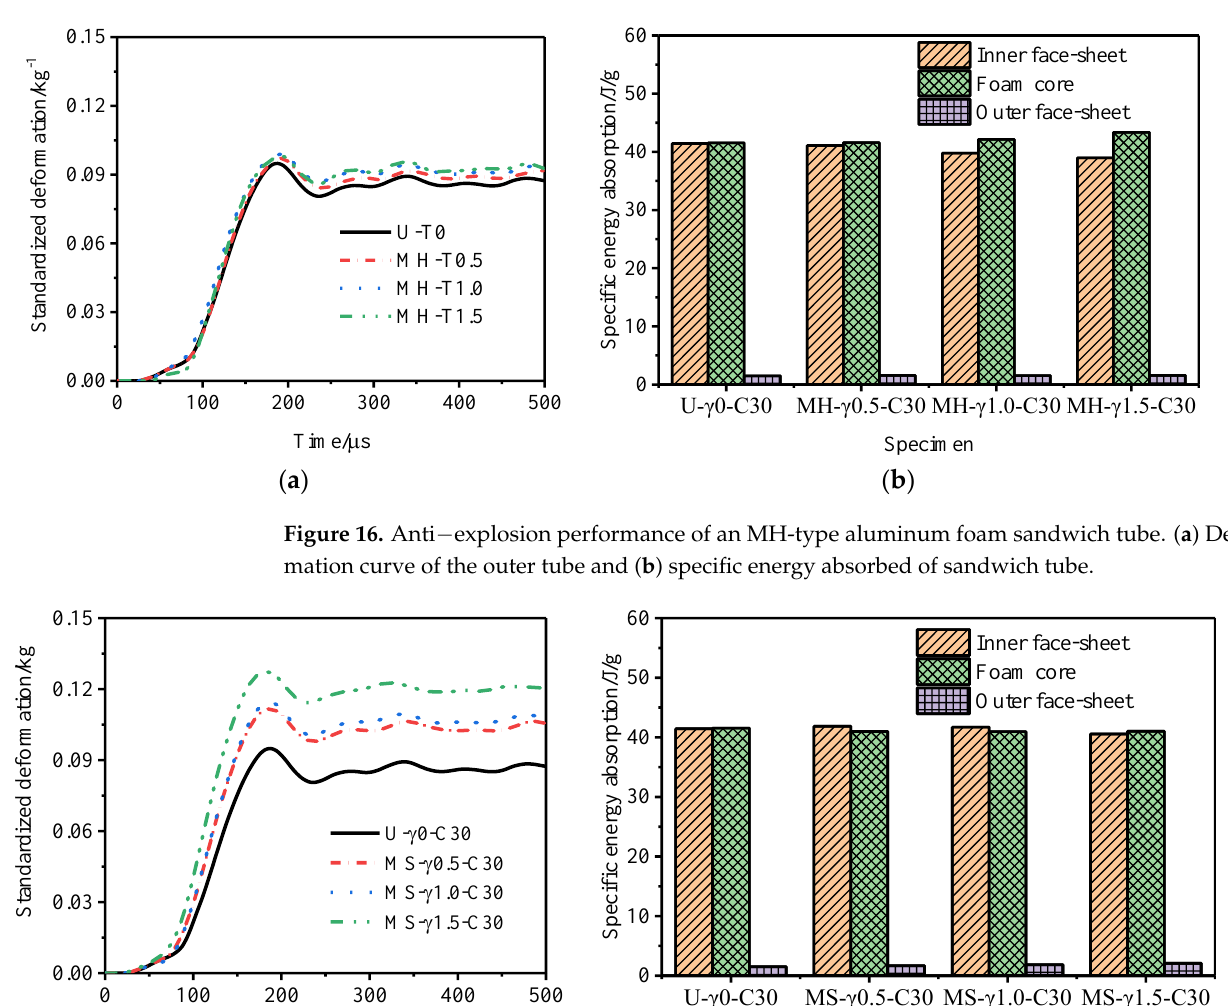
mation curve of the outer tube and ( b ) specific energy absorption of sandwich tube.